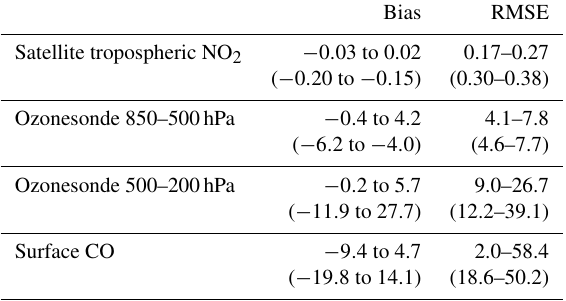
Table 10. Summary of global statistics of the NO 2 , ozone, and CO evaluation results for the reanalysis and the control run (in brack- ets) against tropospheric NO 2 in 10 15 molec . cm − 2 from Table 3, ozonesonde measurements in parts per billion from Table 2, and surface CO measurements in parts per billion from Table